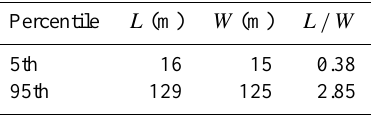
Table 1. 5th and 95th percentiles of length L , width W , and the L/W ratio for selected shallow landslides mapped in the Collaz- zone area. L is measured in the direction of the steepest